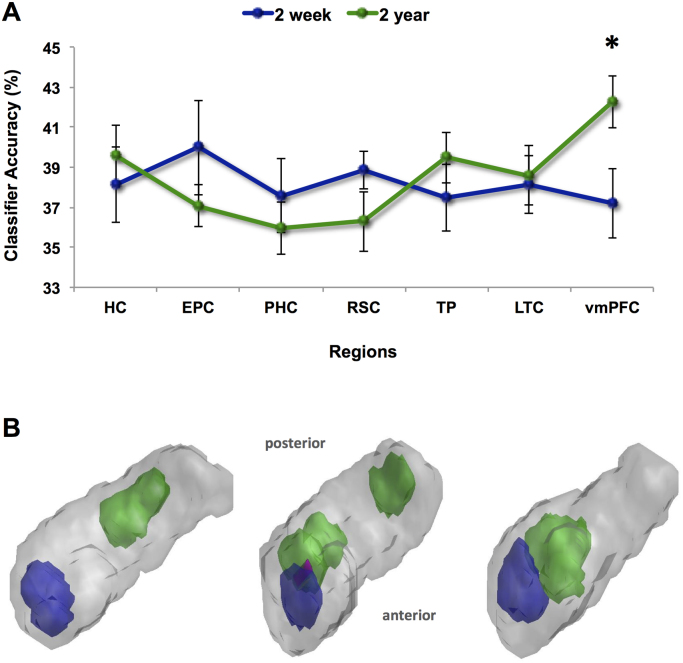
MVPA results for the comparison of the same memories when 2 weeks old and 2 years old. A. Hippocampus (HC), entorhinal and perirhinal cortices (EPC), parahippocampal cortex (PHC), retrosplenial cortex (RSC), temporal pole (TP), lateral temporal cortex (LTC), and ventromedial prefrontal cortex (vmPFC) were examined. Chance=33%. The memories when two weeks old (blue line) and 2 years old (green line) were represented in medial temporal regions, including the hippocampus, while memories were more easily distinguishable when they were 2 years old in vmPFC; *p<0.05. Error bars represent ±1 standard error of the mean. B. Information maps in the hippocampus for the memories when 2 weeks old (shown in blue) and 2 years old (shown in green) comprised the voxel sets that produced above-chance classification accuracy. The information maps for three example participants are shown superimposed upon 3D images of their right hippocampus. Areas in pink denote where the information maps for the memories at the two different time point overlapped. (For interpretation of the references to color in this figure legend, the reader is referred to the web version of this article.).